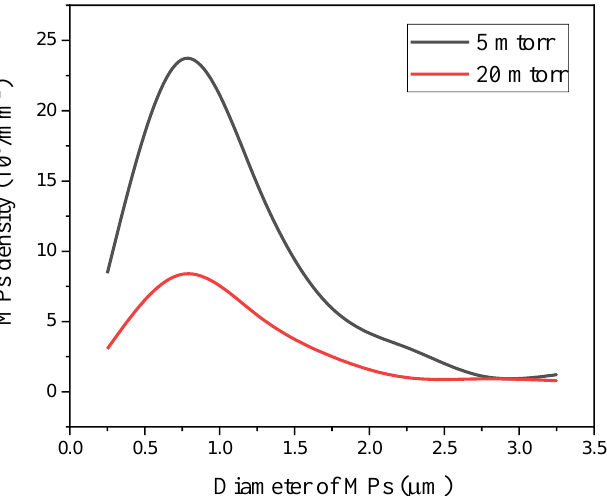
Figure 5. Distribution of MP density with different working pressures: (a) 5 mtorr and (b) 20 mtorr. The distributions of MP density with different inner wall structures and the cross-